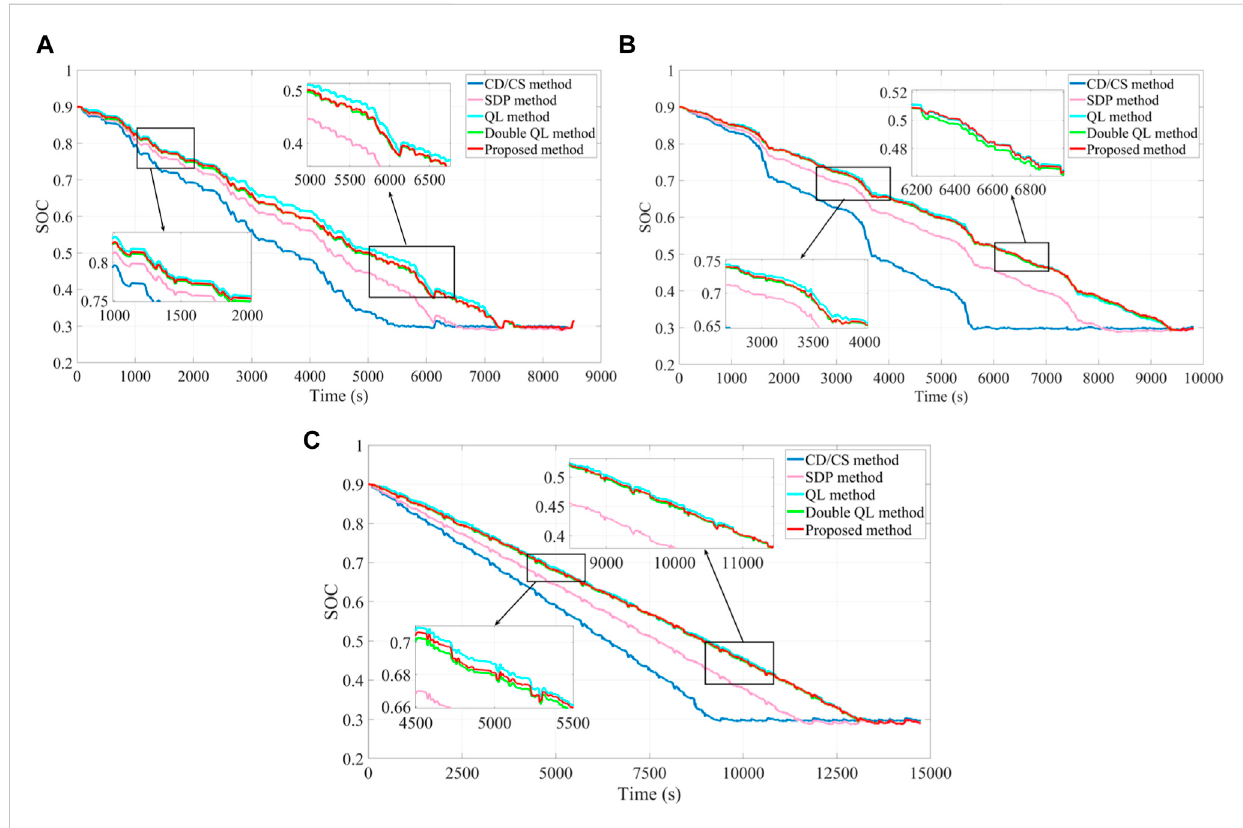
FIGURE 13 SOC curves of different methods: (A) Cycle 1; (B) 5 KM1; and (C) 12